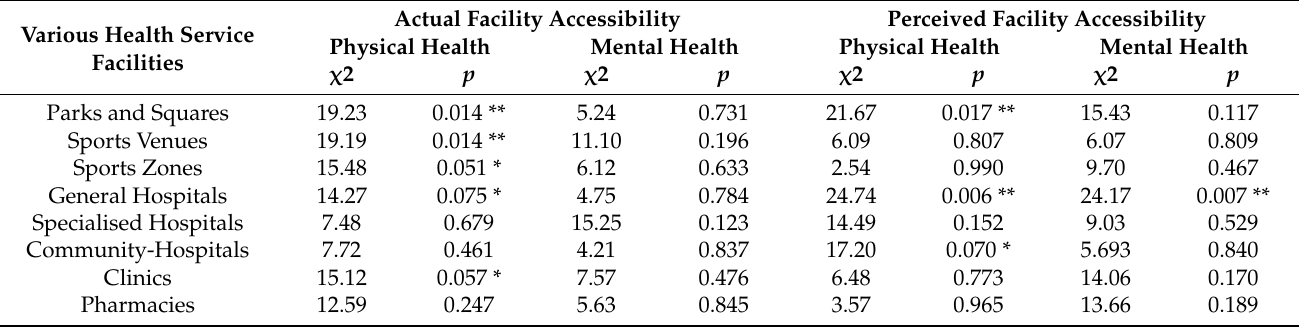
Table 3. Chi-square tests of various health service facilities and